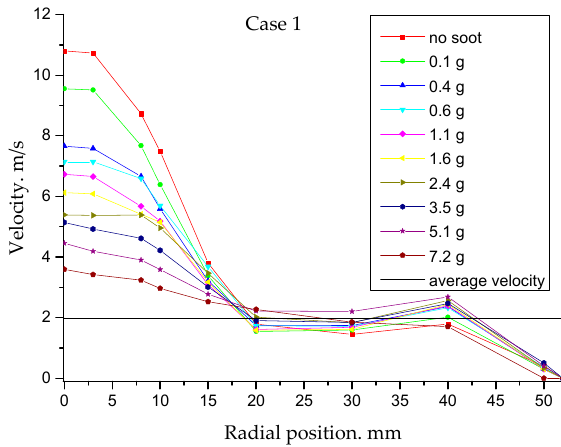
Figure 10. The velocity profile of case 1, conventional cone, the average velocity is 1.98 m / s.